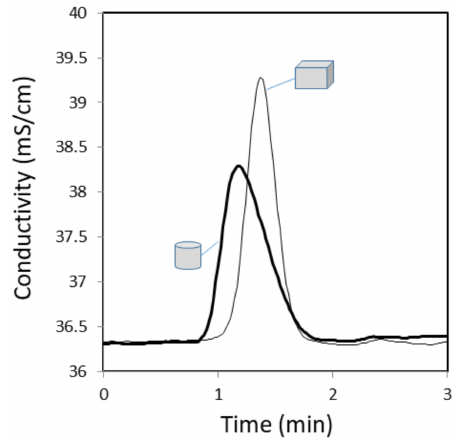
Figure 6. Salt tracer peaks obtained using the surrogate packed-column reactor and the surrogate cuboid packed-bed reactor (bed volume: 5 mL, bed height 25 mm, flow rate: 4 mL/min, superficial velocity: 150 cm/h, media: Capto S, mobile phase: 0.4 M sodium chloride, tracer: 0.8 M sodium chloride, tracer volume: 1 microliters). Table 1. Number of theoretical plates in the surrogate packed-column reactor and the surrogate